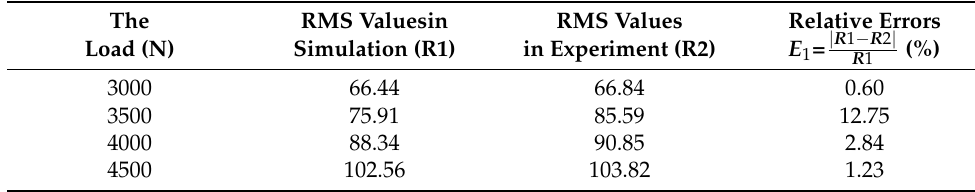
Figure 11. The acoustic pressure amplitude distributions: ( a ) For the load of 4500 N; ( b ) For all these loads. Table 4. The RMS values between Figures 10b and